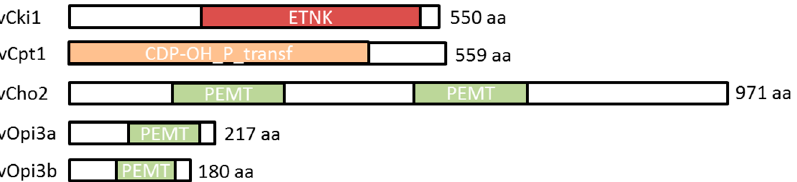
Figure 5. Predicted conserved domains in the phospholipid biosynthetic enzymes of F. velutipes . CDP-